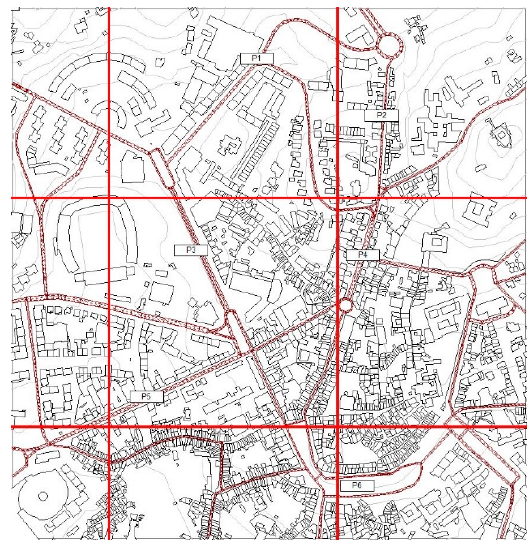
Figure 7. Calculation area and the six selected receiver points.